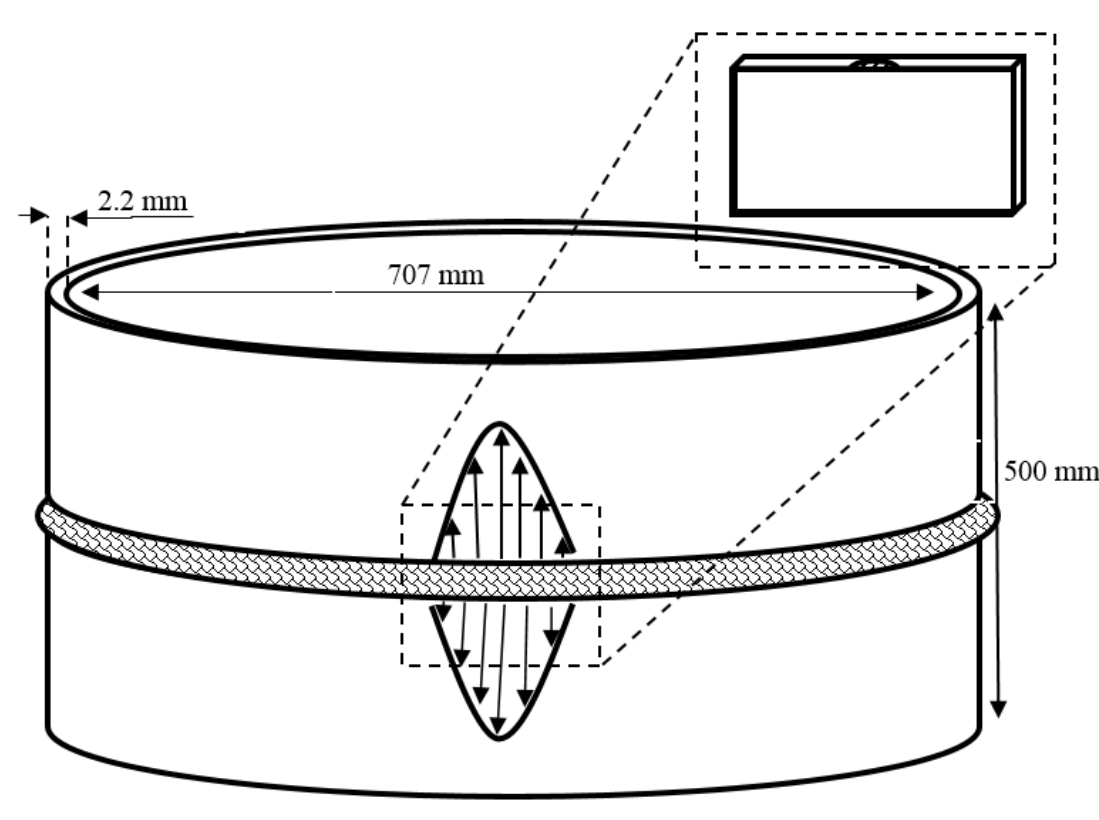
Figure 3. Jet engine AM case.